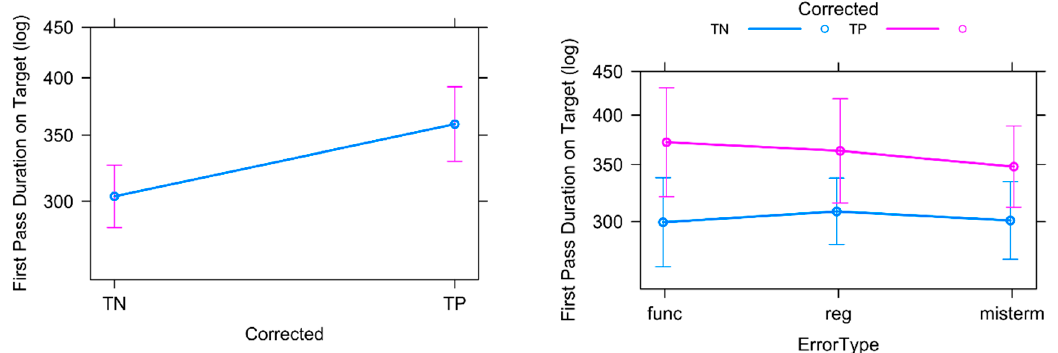
Figure 14. E ff ect of Corrected ( left ) and the interaction Corrected / Error Type ( right ) on target text first Figure 14. Effect of Corrected ( left ) and the interaction Corrected/Error Type ( right ) on target text first pass duration. pass duration.